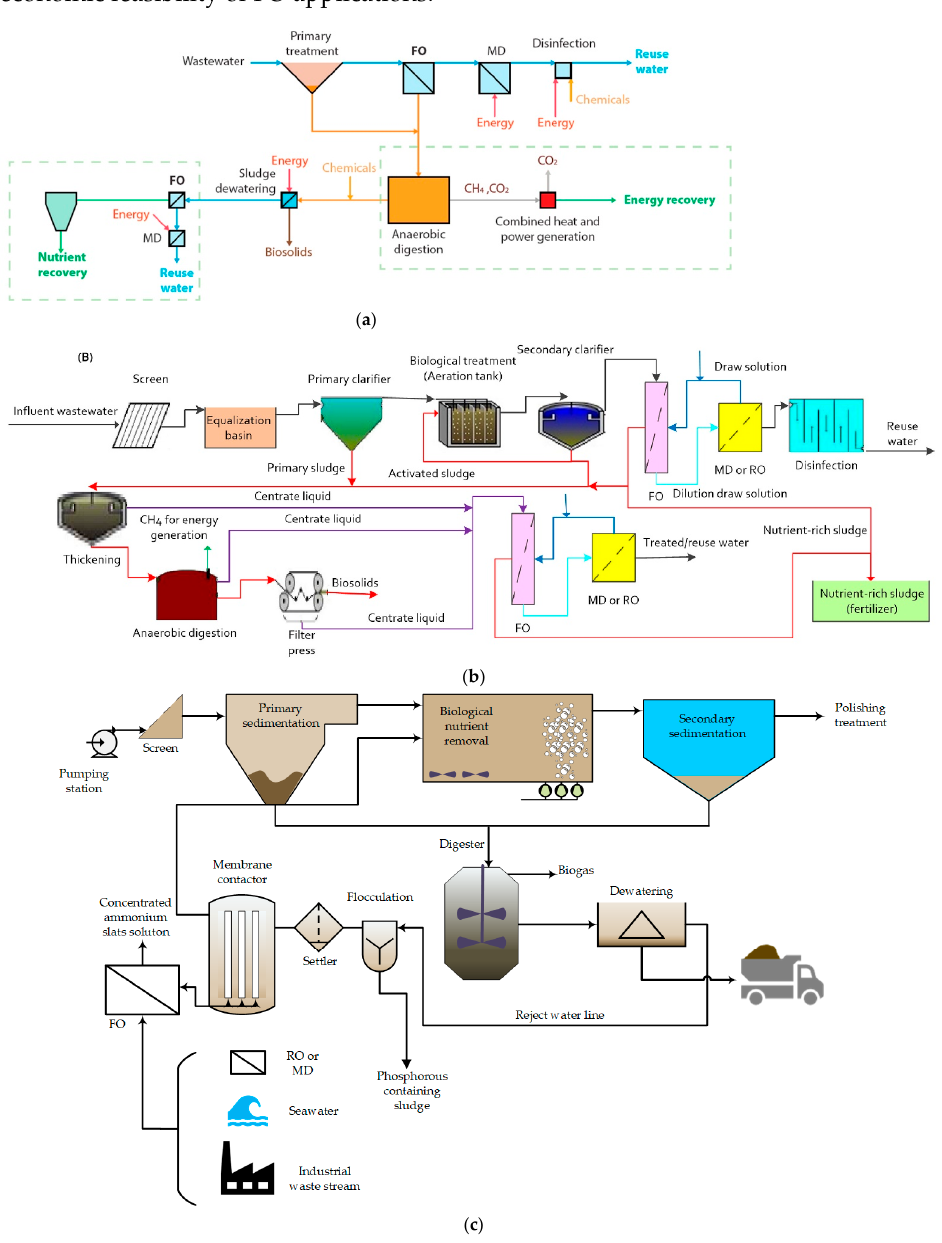
Figure 10. Conceptual large-scale design for FO application for nitrogen recovery from domestic wastewater treatment plant proposed by ( a ) Reprinted from Ansari et al. [13], copyright (2015) with permission from Elsevier, ( b ) Reprinted from Jafarinejad [172] , copyright (2021) with permission from Elsevier and ( c ) this study.